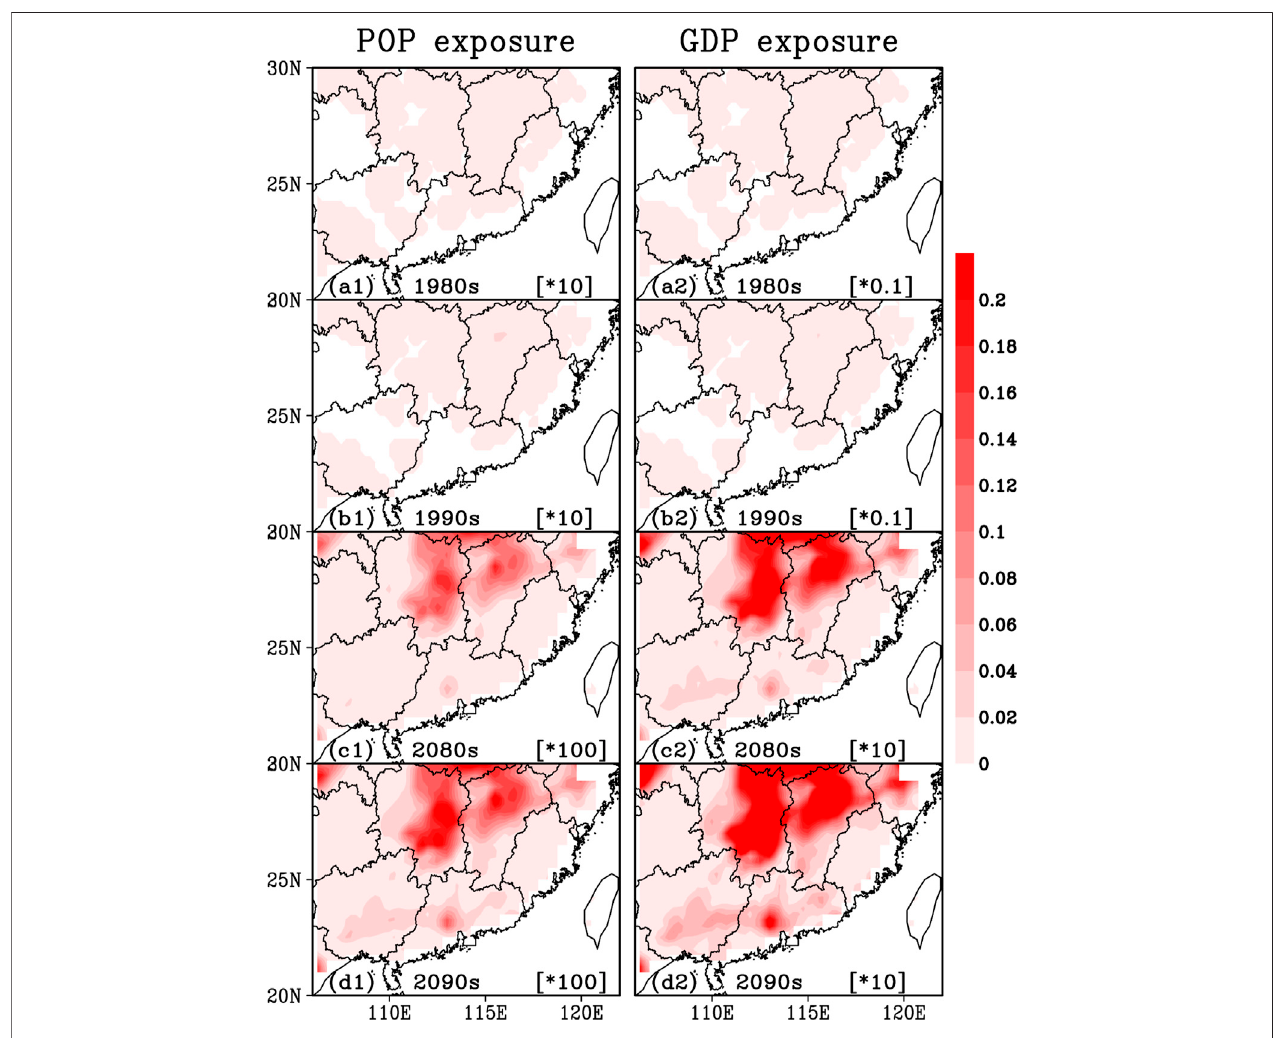
FIGURE 8 | Same as Figure 6 , but for exposure to temperature larger than 40 °